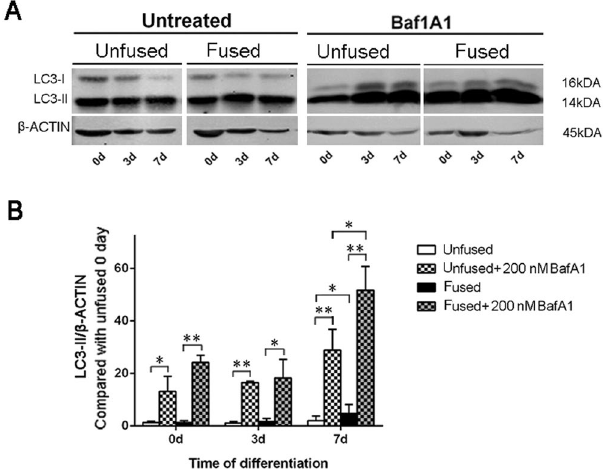
Figure 2. Expression of the autophagosomal marker LC3-II in fused and unfused cranial SMCs. ( A ) Representative western blot of fused and unfused SMCs after 0, 3, and 7 days in osteogenic culture medium. To evaluate autophagic flux, BafA1 was used to block autophagosome and lysosome fusion. Full-length blots are presented in Supplementary Fig. 1. ( B ) Quantification of protein expression by densitometry. Full-length blots are presented in Supplementary Figure 2. Data are expressed as the mean ± SD of three independent experiments. * P < 0.05; ** P < 0.01.